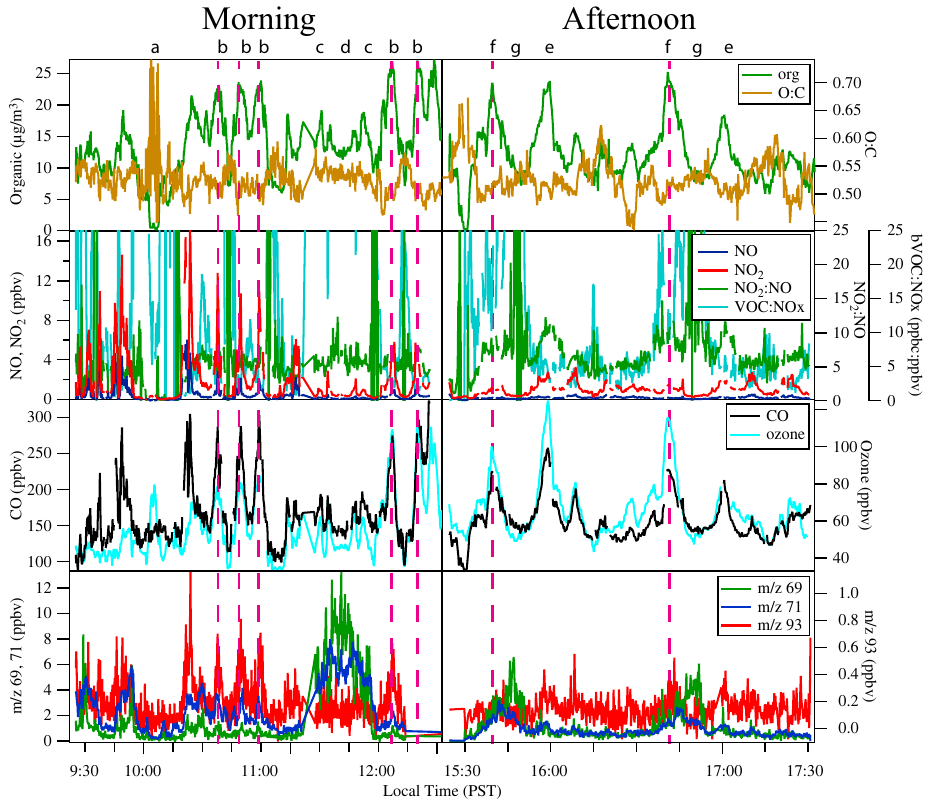
Fig. 4. Organic particle mass, organic particle O:C, CO, ozone, NO, NO 2 , NO 2 :NO, bVOC:NO x , m / z 69 (isoprene), m / z 71 (MVK+MACR), and m / z 93 (toluene) concentrations for the morning and afternoon 28 June flights. Note there is a break in the time axis. The plume transects analyzed for Fig. 5 are indicated by the dashed pink line. Letters at the top of the graph correspond to the flight legs labeled in Fig. 3.